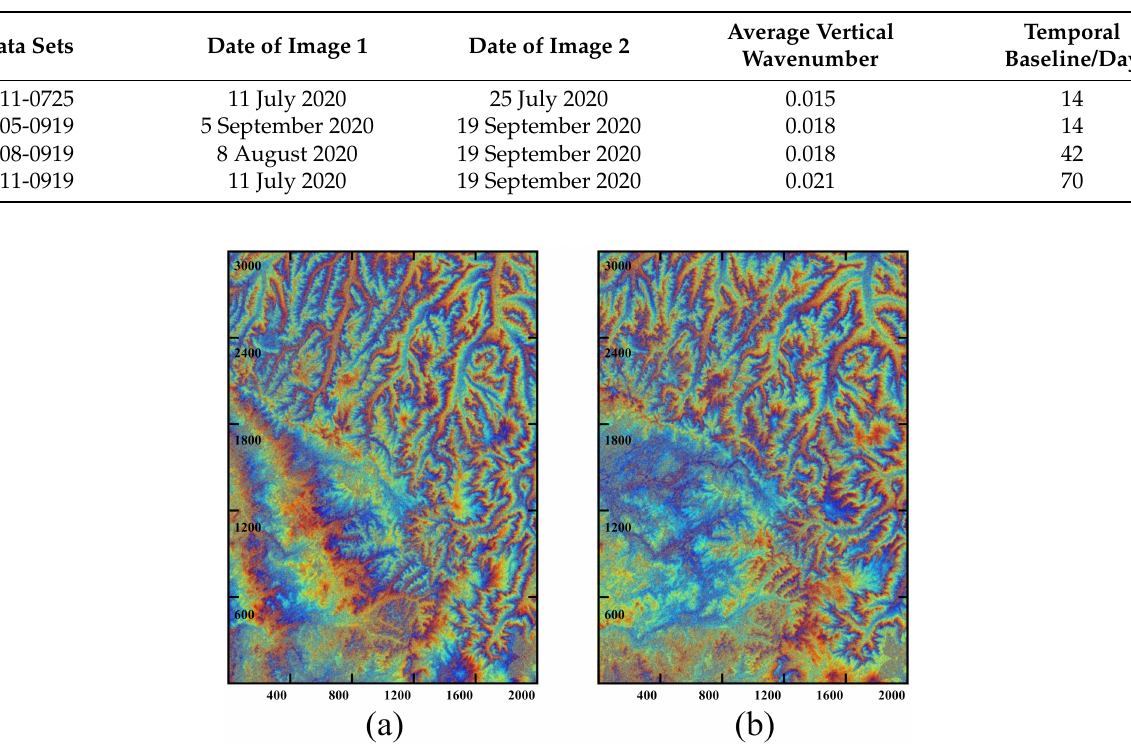
Figure 5. Interferograms before ( a ) and after ( b ) reducing the phase drift and path delay caused by the